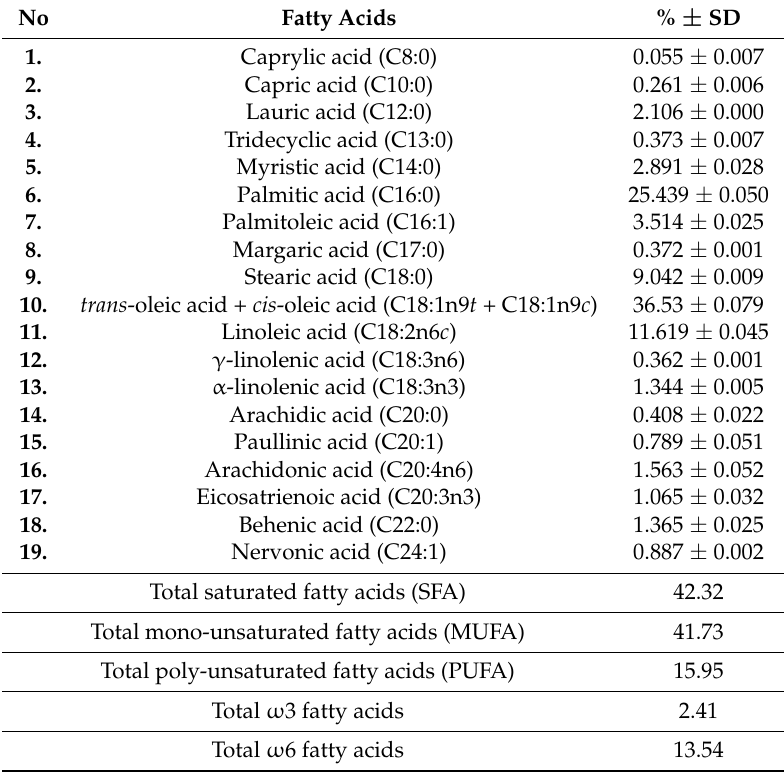
Table 2. Fatty acid content of freeze-dried C. bursa (% of total fatty acid content; SD—standard